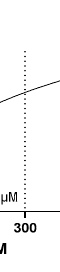
Figure 2. Kinetic properties of recombinant fungal IP 3-4 K enzymes and Hs IPMK. Each enzyme was incubated with ATP (25–400 µ M) and 200 µ M of IP 3 in a 50 µ L reaction volume at room temperature for up to 10 min. Each data point was repeated at least twice. K m and V max values were obtained by fitting all data points to the Michaelis-Menten equation using GraphPad Prism 9 and are presented as the mean ± SEM. V: reaction velocity.